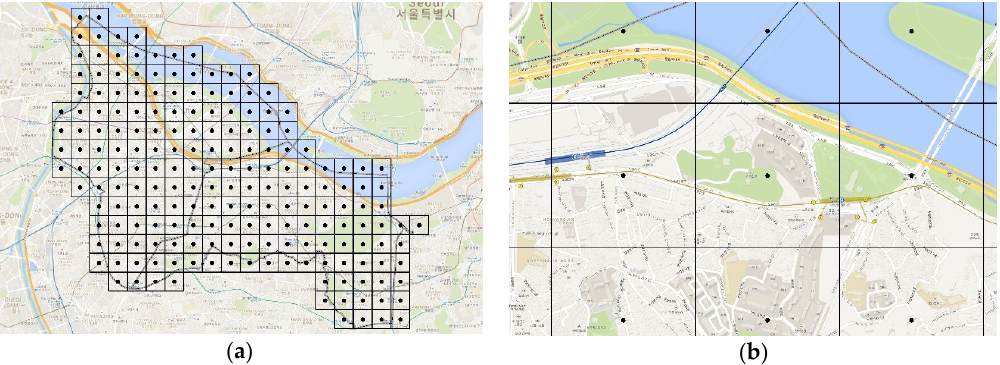
Figure 1. Examples of potential facility points: ( a ) entire area; ( b ) larger scale.